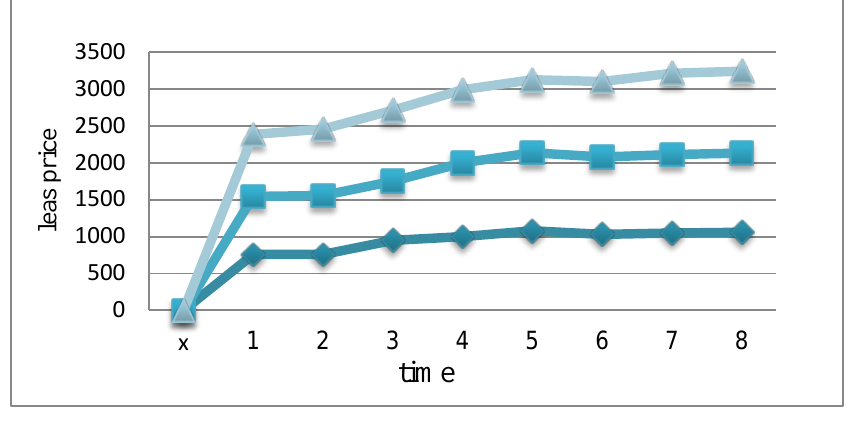
Fig. 1 Output of the model for five